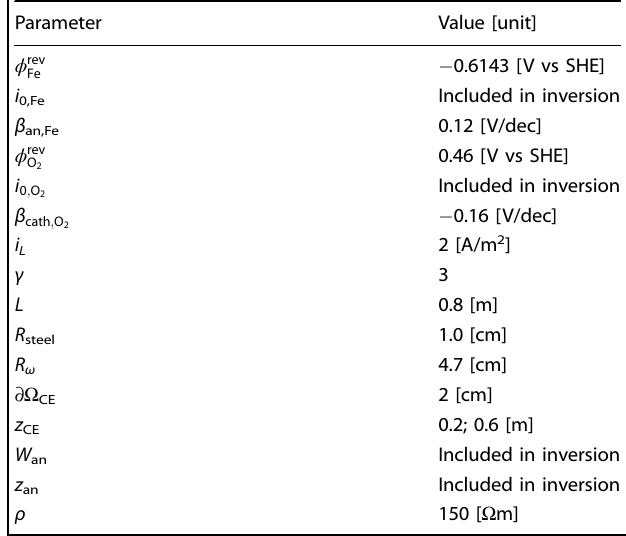
Table 1. Parameters describing the polarization behaviour of the steel (for the anodic and cathodic surface) and model and medium properties of the forward model (see Fig. 9).